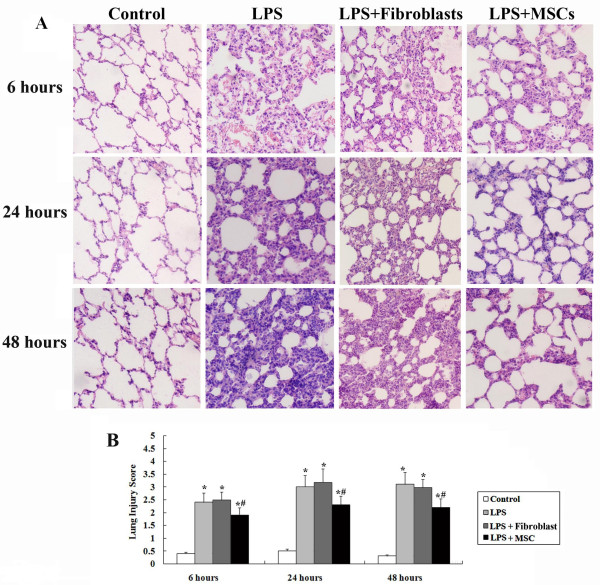
(A) Histological analysis indicated LPS injection caused capillary expansion and congestion, as well as neutrophil infiltration into the lung tissue. In addition, lung septae was noticeably thickened. Administration of UC-MSCs improved the lung injury at all time points. (B) Lung injury score decreased significantly in the MSC + LPS group at all time points (*, p < 0.05 compared with healthy controls; #, p < 0.05 comparing LPS plus UC-MSCs with LPS alone.). Fibroblast injections have no effect on improvement of both pathological morphology and lung injury score.